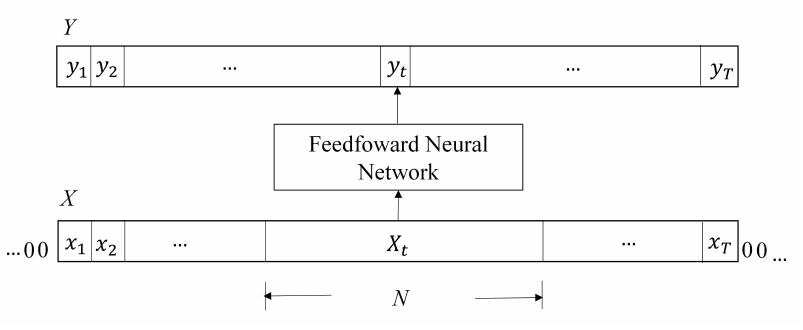
Figure 2. The feedforward operations on X for producing Y